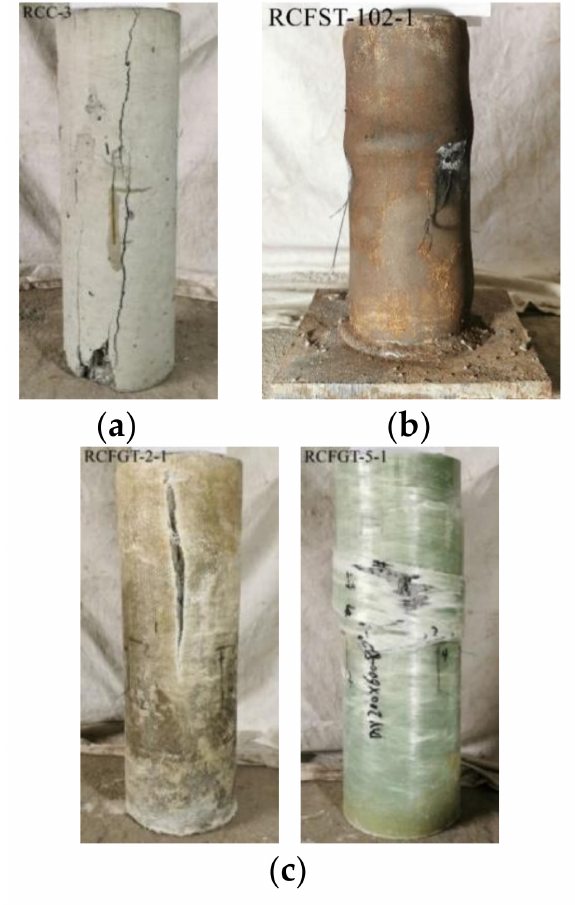
Figure 10. The failure of specimens. ( a ) RCCs; ( b ) RCFSTs; ( c )